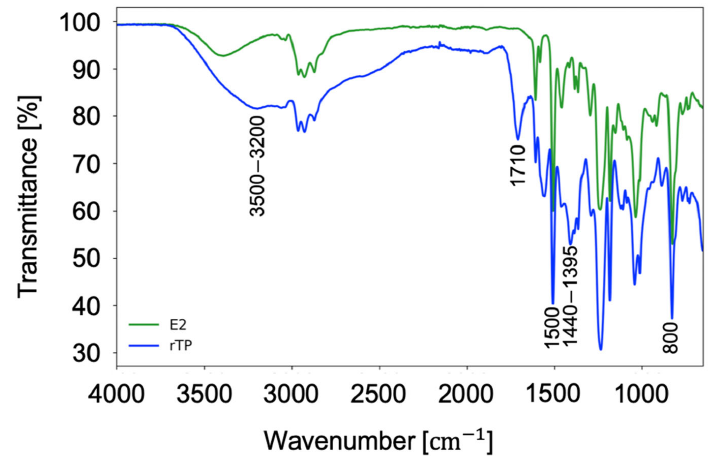
Figure 10. FT ‐ IR acquired spectra for the initial epoxy resin (green curve) and the recycled polymer (blue curve).